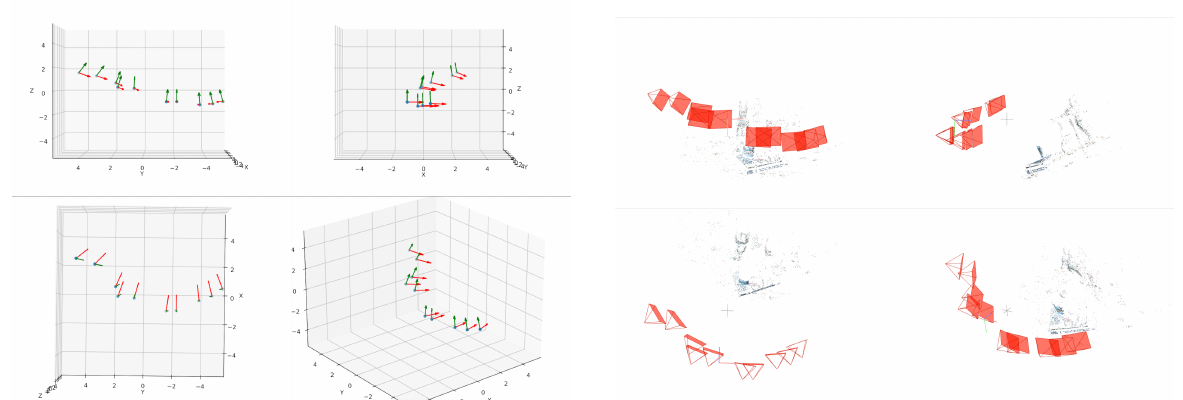
Table 3. Examples of camera parameter representations converted with camorph . On the left side is camorph s visualization, on the right side the same cameras in the COLMAP coordinate